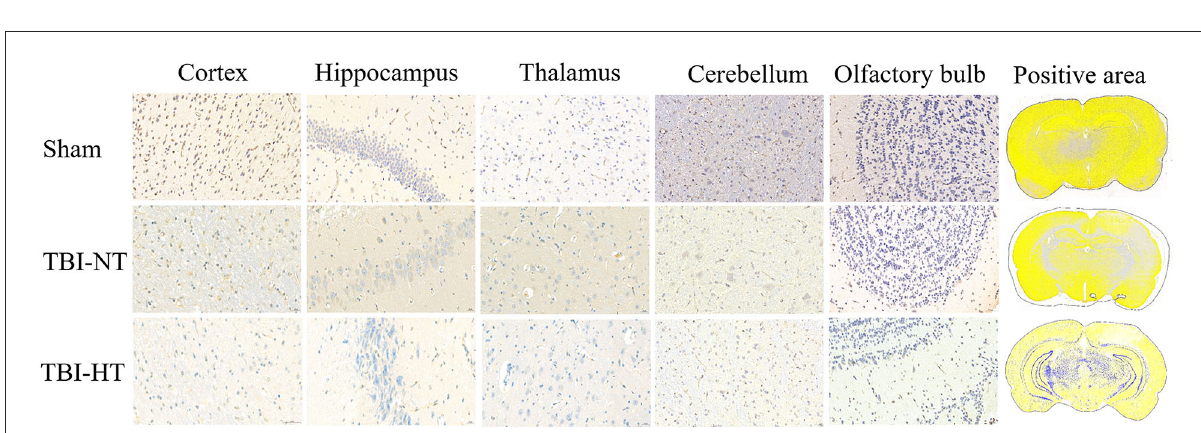
FIGURE10 Representative AQP4 immunostaining photomicrographs and positive staining quantification for cortex, hippocampus, thalamus, cerebellum, and olfactory bulb from sham, TBI-NT, annnd TBI-HT. AQP4 expression across the brain of TBI-HT, characterized by color strength, is weaker than TBI-NT, and TBI-NT is weaker than sham control. The scale bar is 20 µ m in the brain subregion and 1,000 µ m in the whole brain.